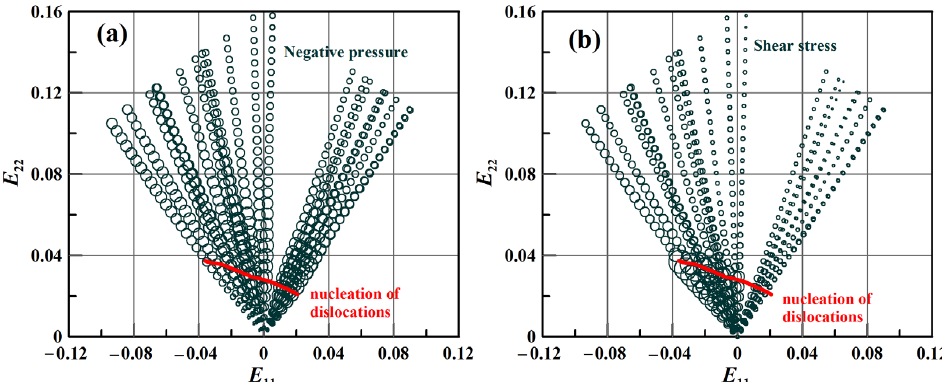
Figure 1. Set of 20 random deformation paths in the space of Green–Lagrange strain tensor components; these deformation paths are investigated by means of MD simulations. The deformation paths are represented by bubble plots, with the bubble size proportional to the absolute value of ( a ) negative pressure and ( b ) shear stress. The red line shows the threshold of dislocation nucleation. The data are taken for the case of Al with spherical pores 8 nm in diameter at 300 K.